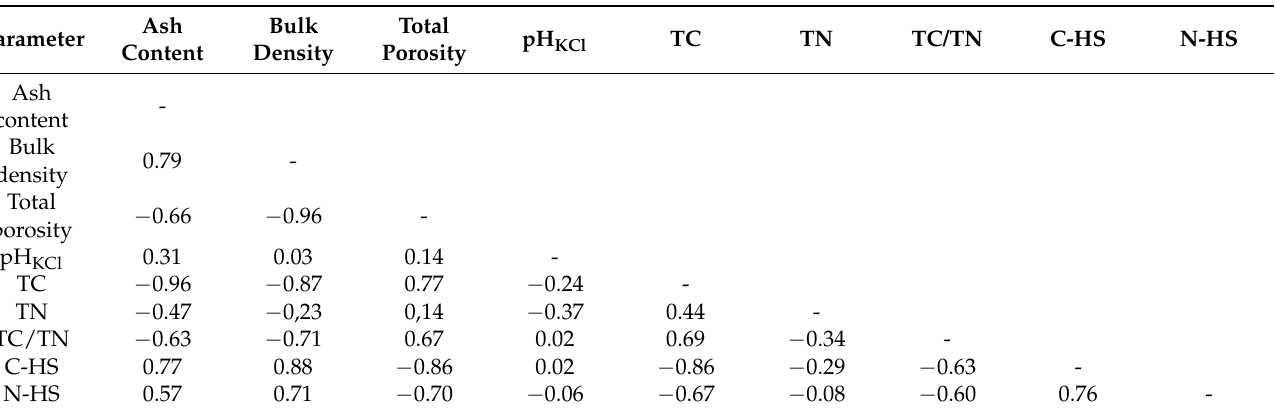
Table 6. Correlation matrix for physical and chemical soil properties.